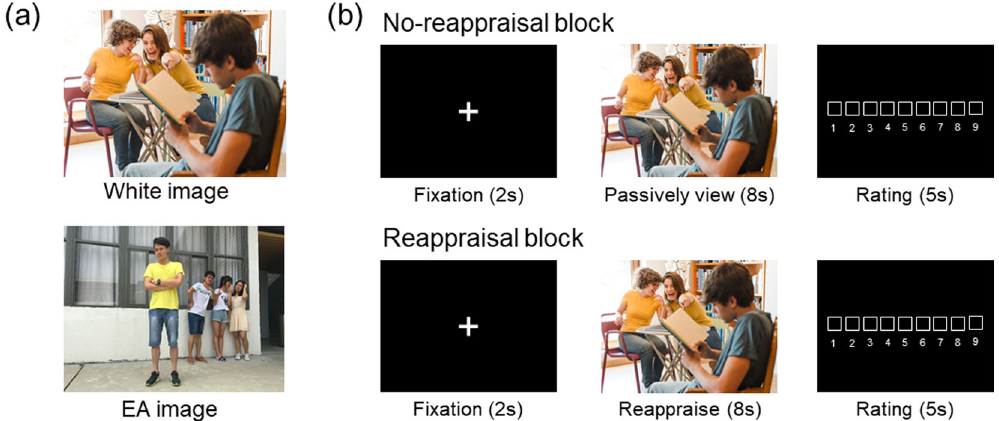
Fig. 1 Experimental paradigm and sample images. a Sample images of social exclusion with White or East Asian characters (White or EA images for short). The sample White image was designed by Freepik and the license allows the picture to be freely used. For the sake of copyright, the persons in the sample EA image are replaced by the graduate students in the research group. All the four persons in the picture gave their consent for the material to appear in academic journals. b Stimulus presentation in one experiment trial. EA, East